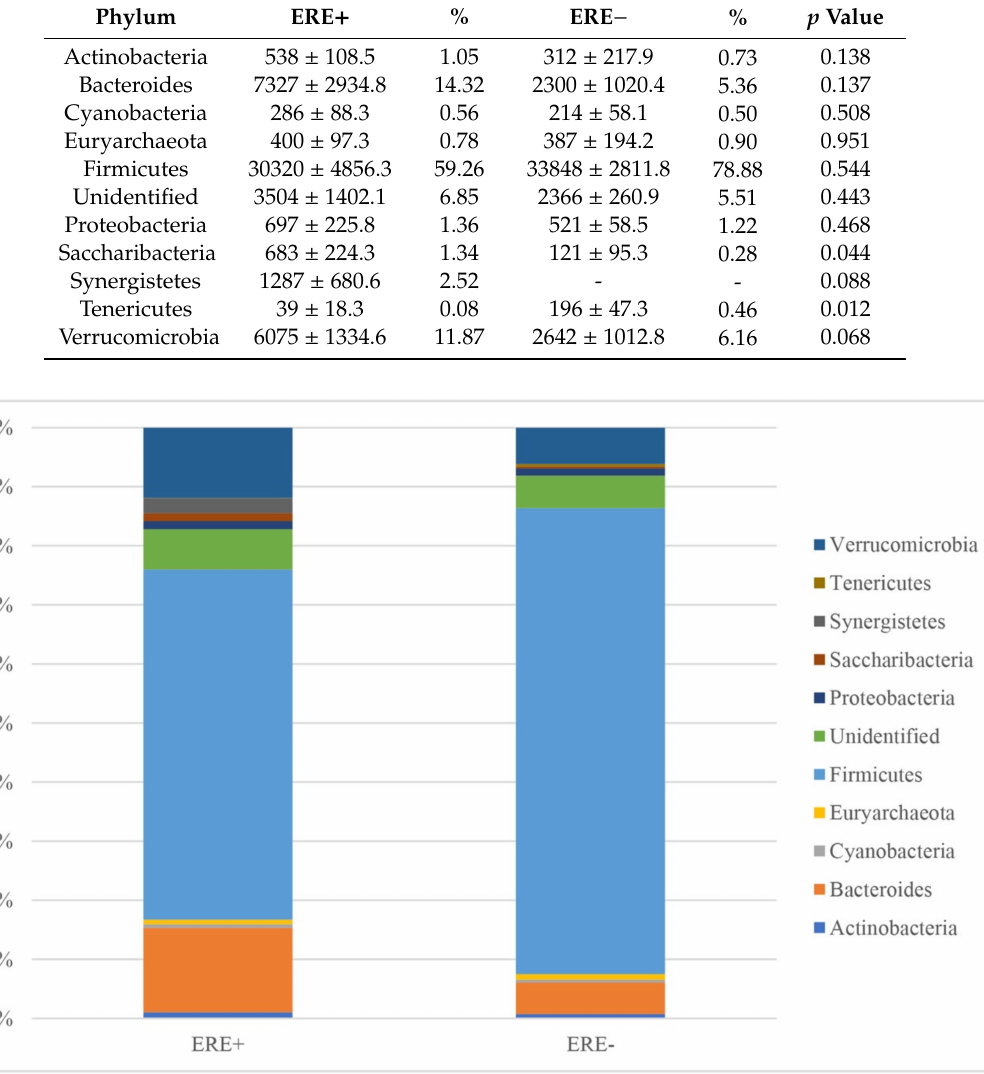
Table 2. Mean abundance (n = 6 relative to health status) with standard error and percentage of the bacterial phyla of the cecal contents of rabbits with and without ERE. Where a phylum was not observed is denoted by “-“.